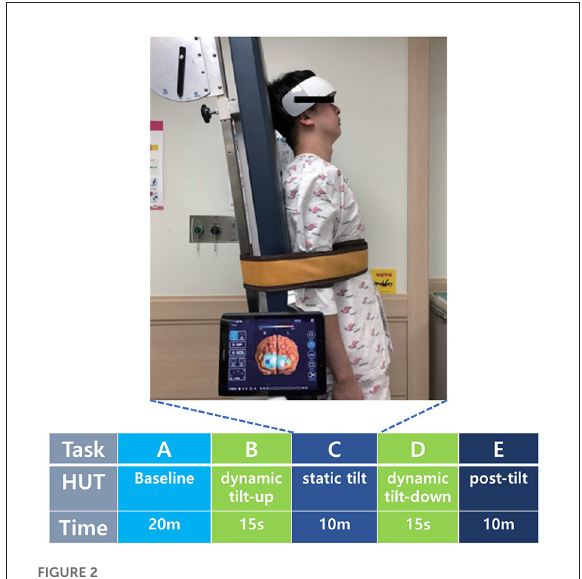
FIGURE2 Cerebral hemodynamics were observed during the five HUT tasks using the fNIRS device attached to the frontotemporal area. HUT timeline consisted of baseline (Task A), dynamic tilt-up (Task B), static tilt (Task C), dynamic tilt-down (Task D), and post-tilt (Task E) phases. fNIRS, functional near-infrared spectroscopy; HUT, head-up tilt table test; m, minute; s, second. Patient informed consent was obtained for the use of personally identifiable photos for